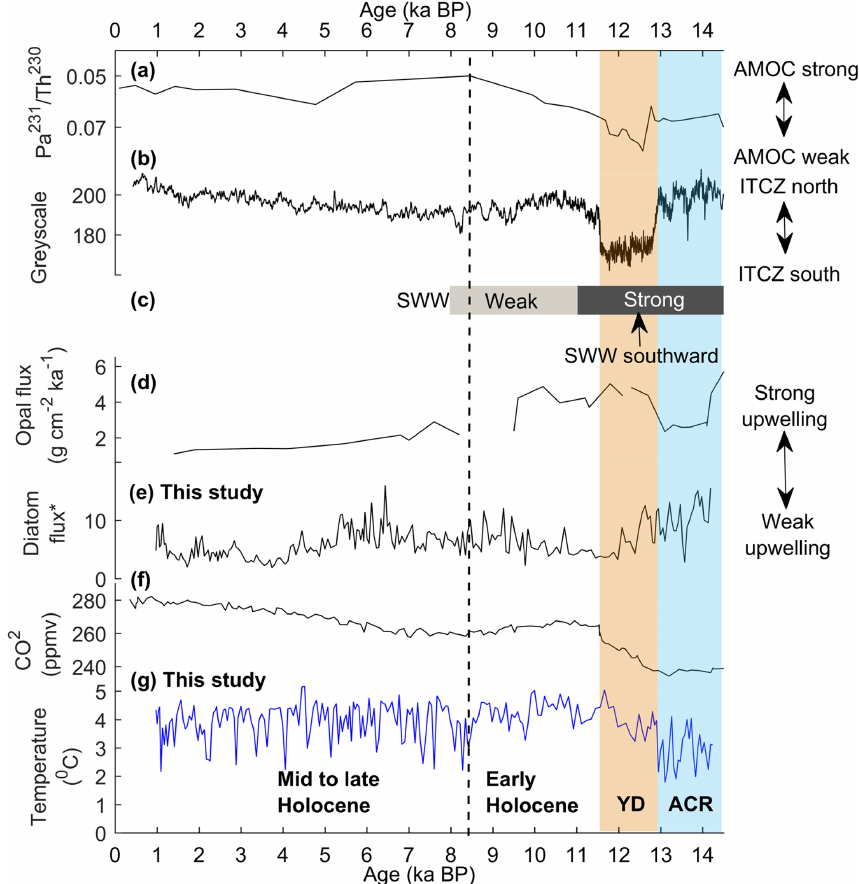
Figure 8. Summary of key reconstructions showing the late deglacial to Holocene variations in the AMOC, atmospheric circulation and Southern Ocean. (a) AMOC reconstruction based on Pa 231 / Th 230 from a core from the western subtropical North Atlantic (McManus et al., 2004); (b) greyscale measurements from cores from the Cariaco Basin related to productivity, interpreted as reflecting ITCZ position (Hughen et al., 1996); (c) summary of reconstructed SWW strength based on a collation of palaeoclimate data from the southern mid- latitudes (41–52 ◦ S; Fletcher and Moreno, 2011); (d) upwelling in the Atlantic sector of Southern Ocean (core TN057-13PC4) based on opal flux (Anderson et al., 2009; Divine et al., 2010); (e) productivity at the Conrad Rise inferred from the diatom flux in COR1GC; ∗ measured in units: 10 9 diatomscm − 2 kyr − 1 ; (f) EDC CO 2 reconstruction (Monnin et al., 2001); (g) COR1GC reconstruction of SST (this